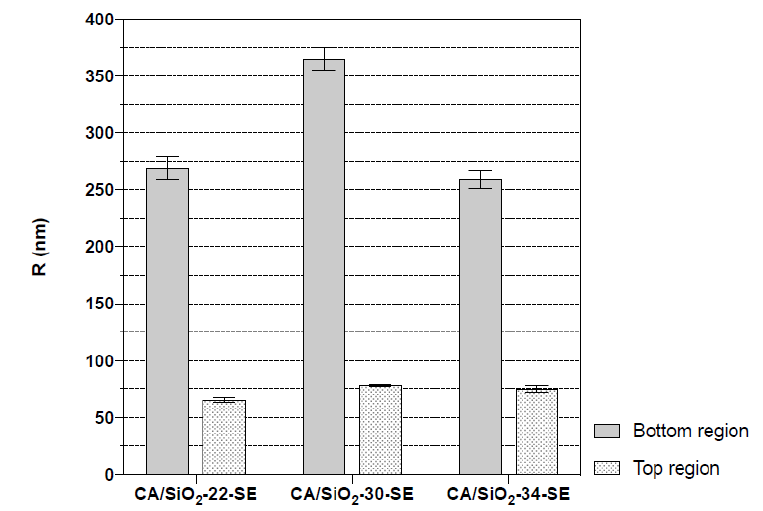
Figure 8. Average cavity radius of CA/SiO 2 -SE membranes in a region near the membrane’s bottom and close to the membrane’s top active layer.